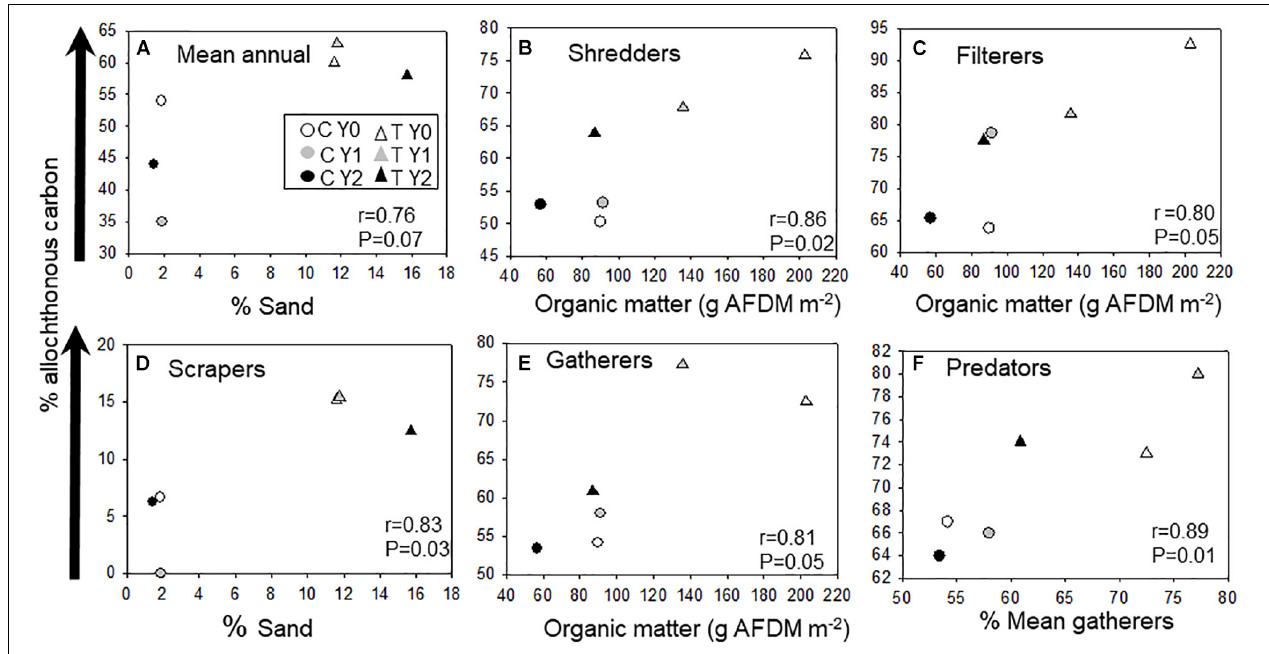
FIGURE 2 | Pearson product moment correlations between (A) annual average macroinvertebrate community δ 13 C values, (B) macroinvertebrate shredders, (C) filterers, (D) scrapers, (E) filterers, and (F) predators and environmental variables. Control (C) upstream reach without wood addition and treatment (T) with wood added. Arrow indicates a gradient of the proportional increase in allochthonous C assimilation. Organic matter is coarse benthic organic matter fractions > 1